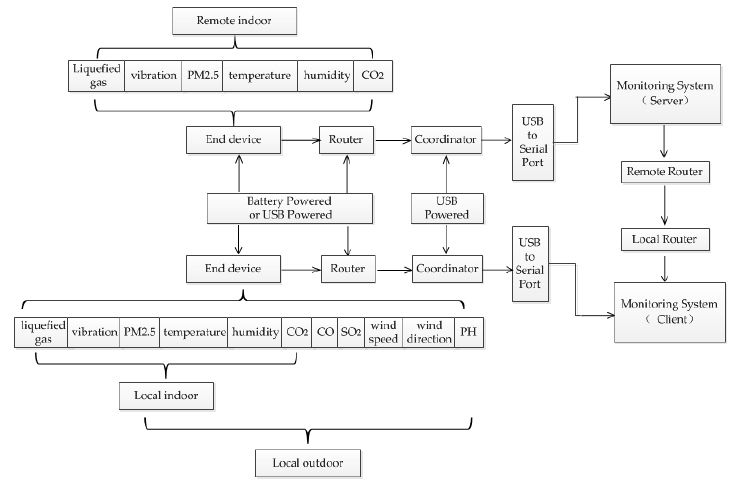
Figure 1. The layout of overall system.